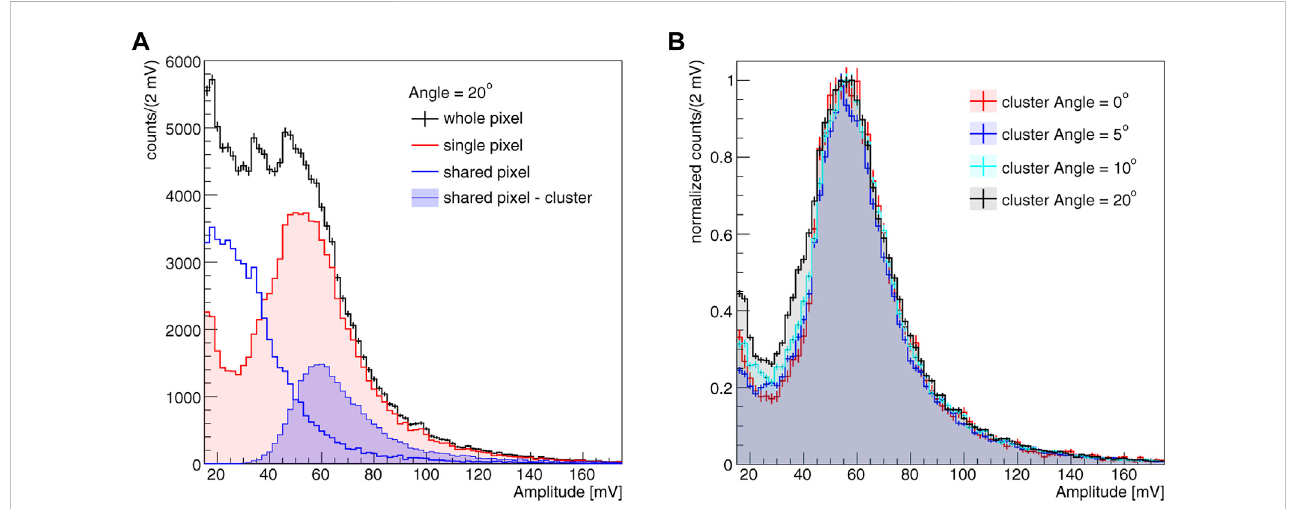
FIGURE 12 (A) Amplitudedistributionsat20 ° withrespecttonormalincidencefordifferenteventcategories; (B) Clusteramplitudeatvariousparticleincidentangles.